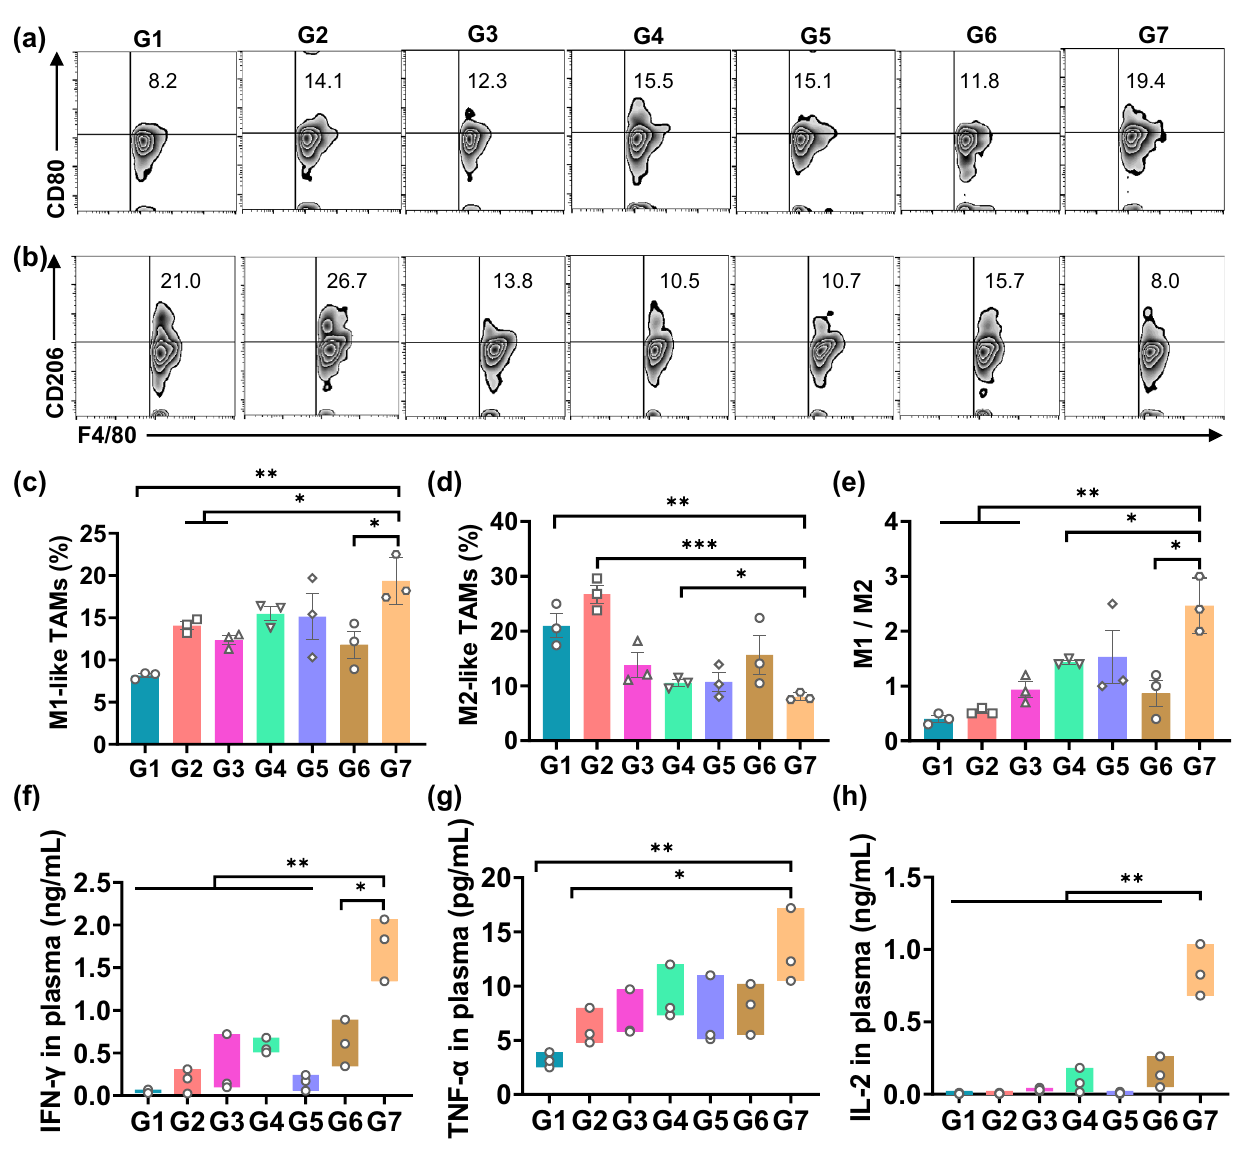
Fig. 5 Modulation of TAMs on tumor resected mice induced by DLG matrix-based treatment strategy. G1–G7 are identical to the groups in Fig. 4. a , b Representative flow cytometric analysis of M1-like TAMs (CD80 + ) and M2-like TAMs (CD206 + ) gating on F4/80 + CD11b + cells. c , d Relative quantification of the proportions of M1-like TAMs (CD80 + ) and M2-like TAMs (CD206 + ) gating on F4/80 + CD11b + cells. Data are shown as mean ± SEM ( n = 3). e The ratio of M1/M2 in different groups. Data are shown as mean ± SEM ( n = 3). f–h Cytokine levels (IFN-γ, TNF-α, IL-2) isolated from the plasma of the mice in different treatment groups on Day 8 after surgery. Data are shown as mean ± SEM ( n = 3). The statistical comparison between groups was performed following the student’s t test (two-tailed). * p < 0.05 and ** p <